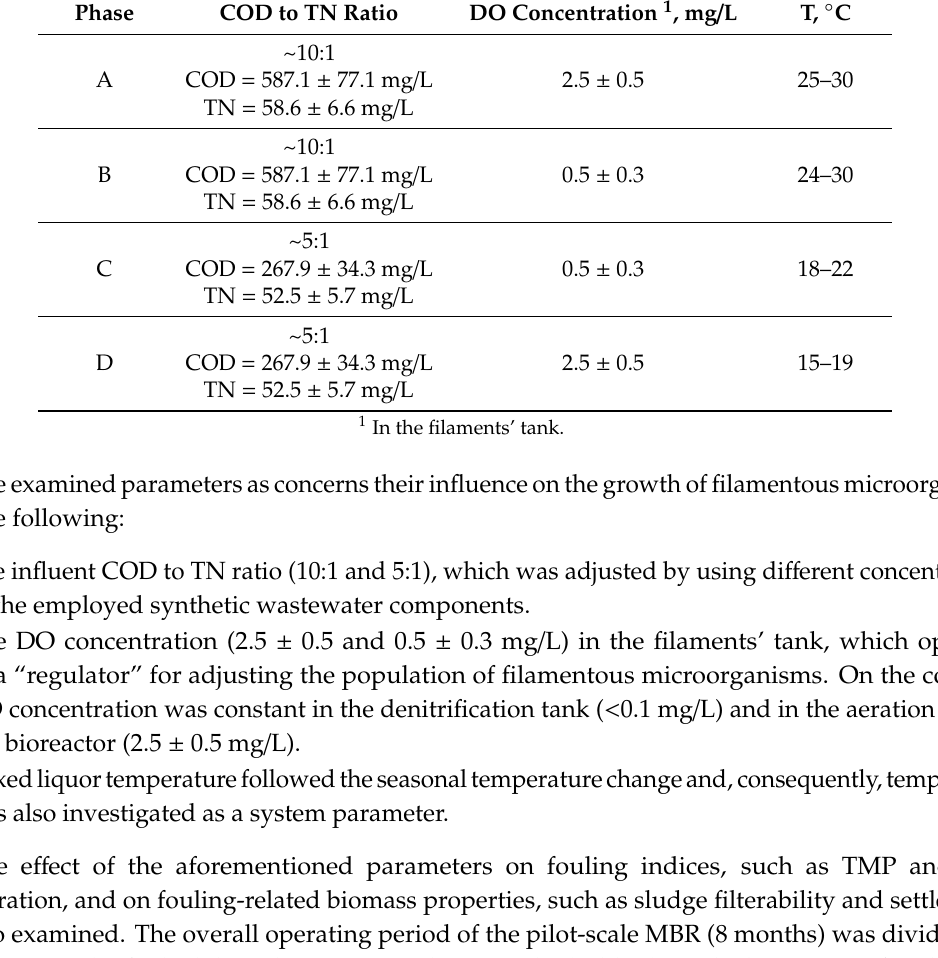
Table 1. Examined parameters in the pilot-scale Membrane Bio-Reactor (MBR). Phase COD to TN Ratio DO Concentration 1 , mg /